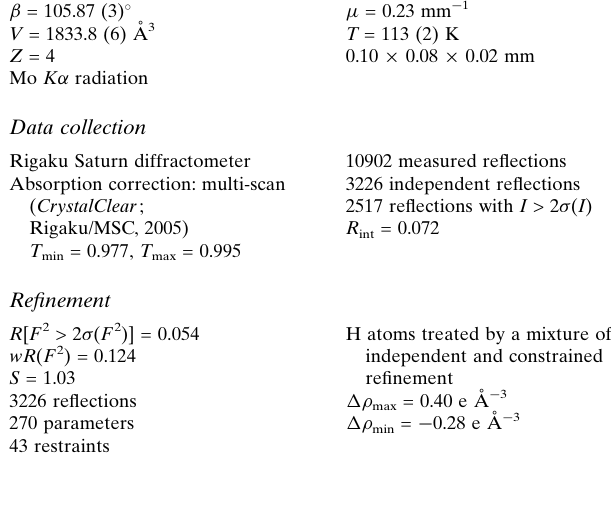
Hydrogen-bond geometry (A˚ , (cid:3) ). D —H (cid:1)(cid:1)(cid:1)